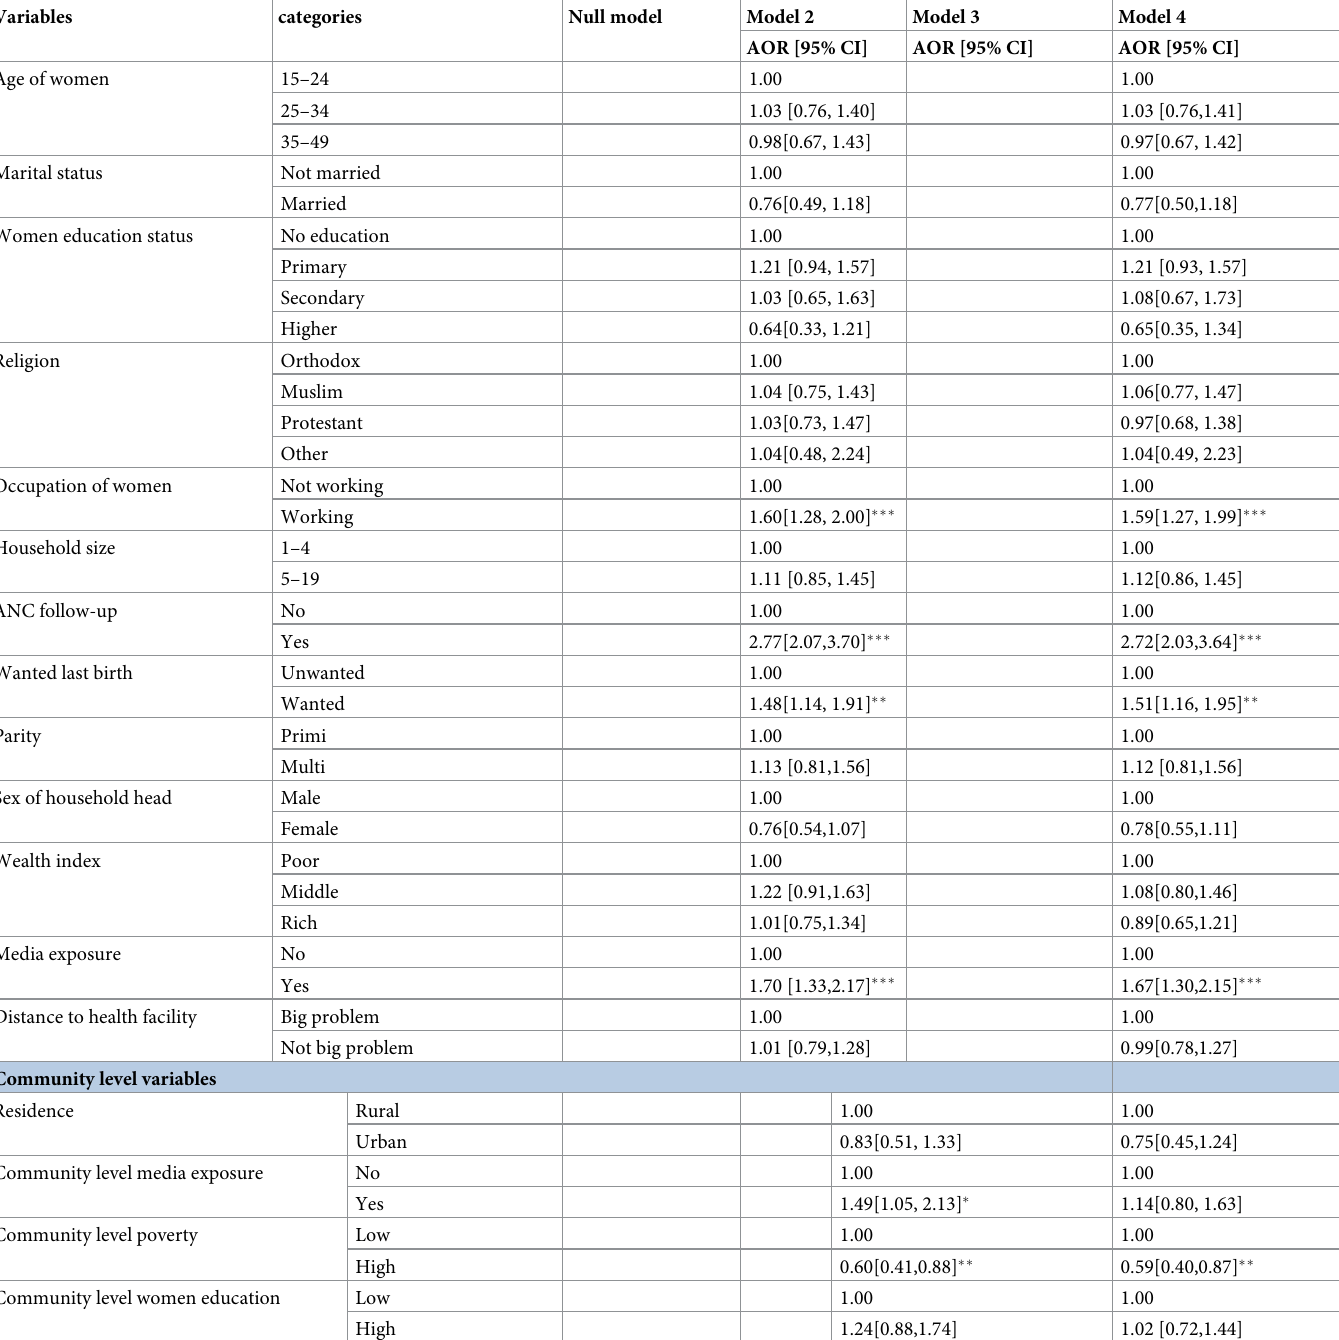
Table 4. Multilevel multivariable analysis of factors associated with utilization of Deworming Drugs among pregnant women in Ethiopia, EDHS